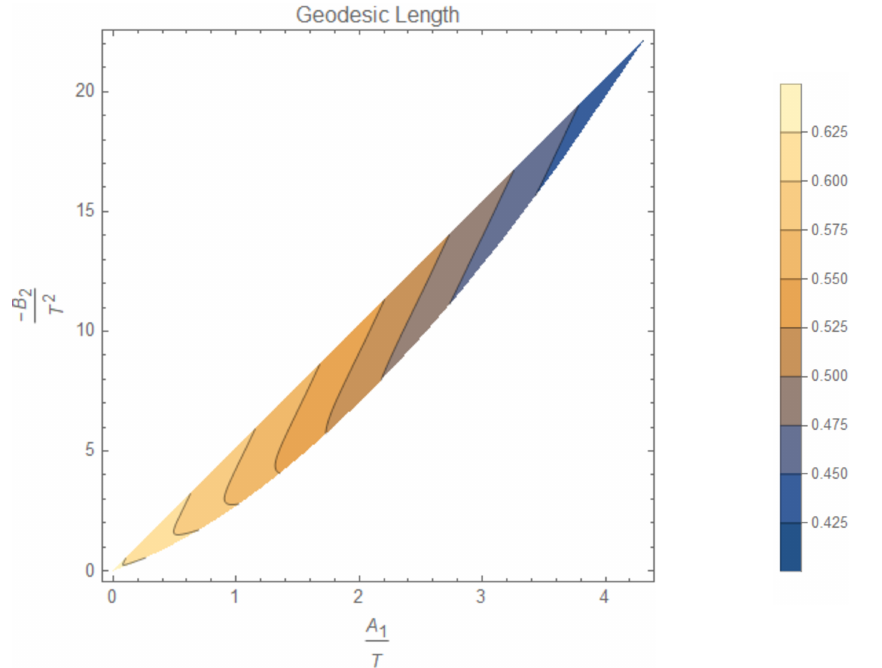
Figure 11. A representative contour plot of the renormalized geodesic length connecting the end points on the right and the left boundaries, where the corresponding operator is localized. In this particular case, we have set the boundary time t b = 0 for convenience. We have shown the dependence of the renormalized geodesic length as a function of the deformation parameters, a la equation (4.11) in the supergravity